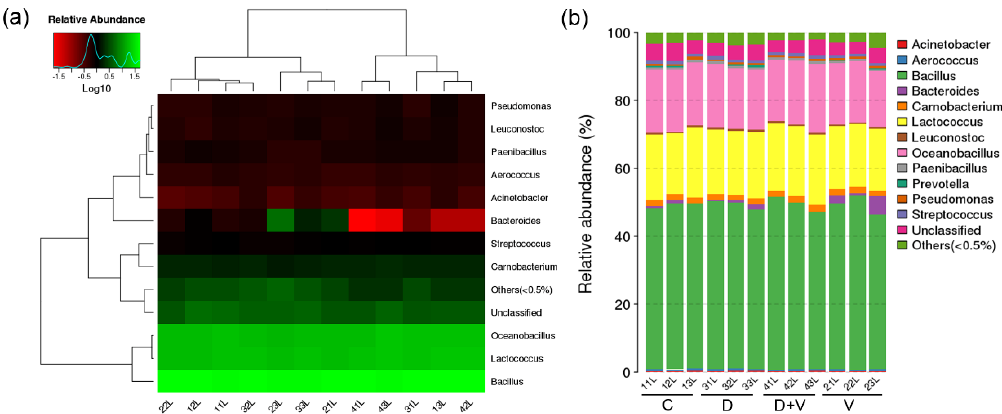
Figure 5. Microbial diversity and species abundance of pulmonary flora. ( a ) Log-scaled percentage heat map at the genus level. Longitudinal clustering indicates the similarity of all species among different samples, while the horizontal clustering indicates the similarity of certain species among different samples. The closer distance and the shorter branch length represent the similarity in the species composition between the samples. ( b ) The taxonomic composition distribution in samples at the genus level. The taxonomic composition distribution histograms of each sample were shown at the genus level and directly displayed as the ratio of each species. The species where abundance was lower than 0.5% were classified into “others”. Group designations were as follows: control (C); virus infection model (V); dysbacteriosis model (D); dysbacteriosis and virus infection (D + V).